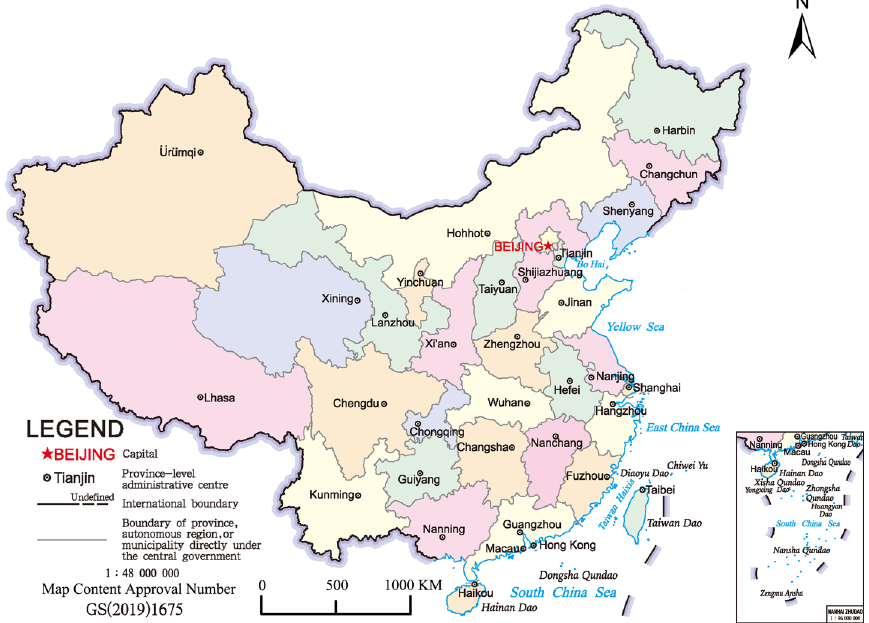
Figure 1. The distribution of China’s provincial capitals. (Map source: http://bzdt.ch.mnr.gov.cn/index.html, accessed on 1 January 2022).